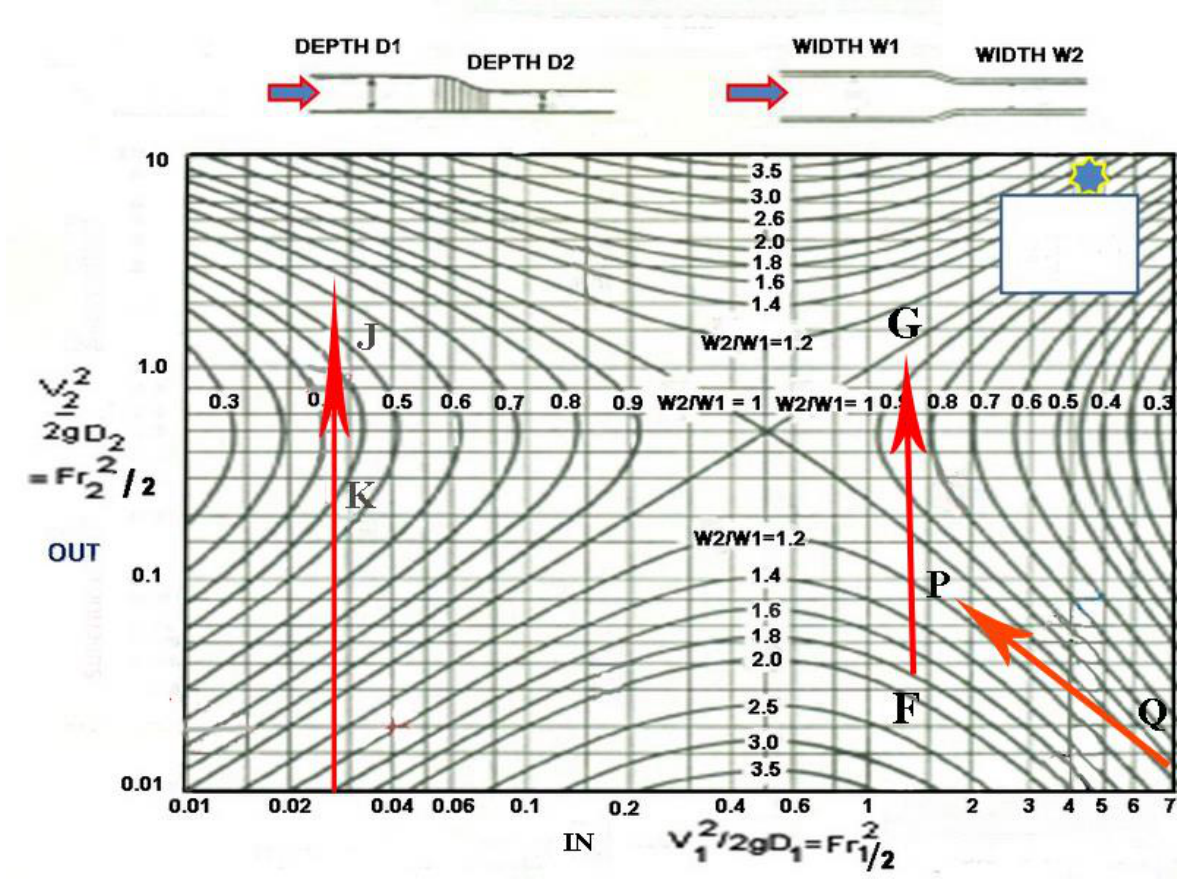
Figure 15. Flow plot describing flow transitions in channels. The x-axis describes Froude number channel entry (IN) conditions; the y-axis describes Froude number channel exit conditions (OUT). The W2/W1 curves describe the contraction (W2/W1 < 1) or expansion ratio (W2/W1 > 1) of a channel sequence. Figure derived from [10] (Bakhmeteff 1932:254, his figure 193b). Here the high Froude number range is applicable to the Main Aqueduct segment in the hydraulic jump area as later detailed. (Figure additions by C. Ortloff).